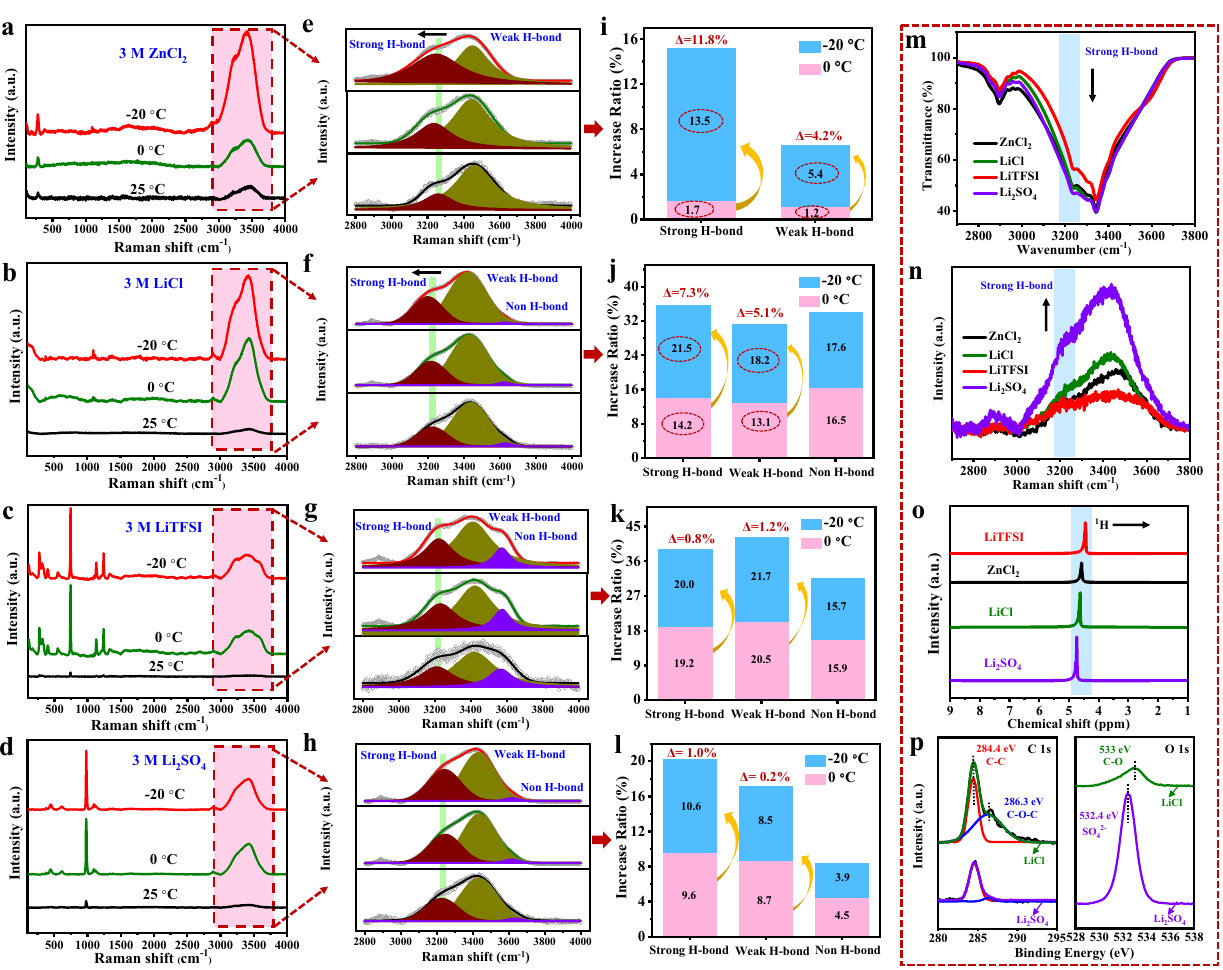
Fig. 3 a‑d Raman spectra of different hydrogel electrolytes (the scan range is 100–4000 cm −1 ). e – h Fitted O–H stretching vibrations represent electrolytes with strong, weak, and non-H-bonds. i – l Increase ratios of H-bonds at 0 °C and −20 °C compared with 25 °C. m FTIR spectra, n Raman spectra, and o 1 H NMR spectra of different hydrogel electrolytes. p high-resolution C 1 s and O 1 s of XPS survey spectra from 3 M LiCl and 3 M Li 2 SO 4